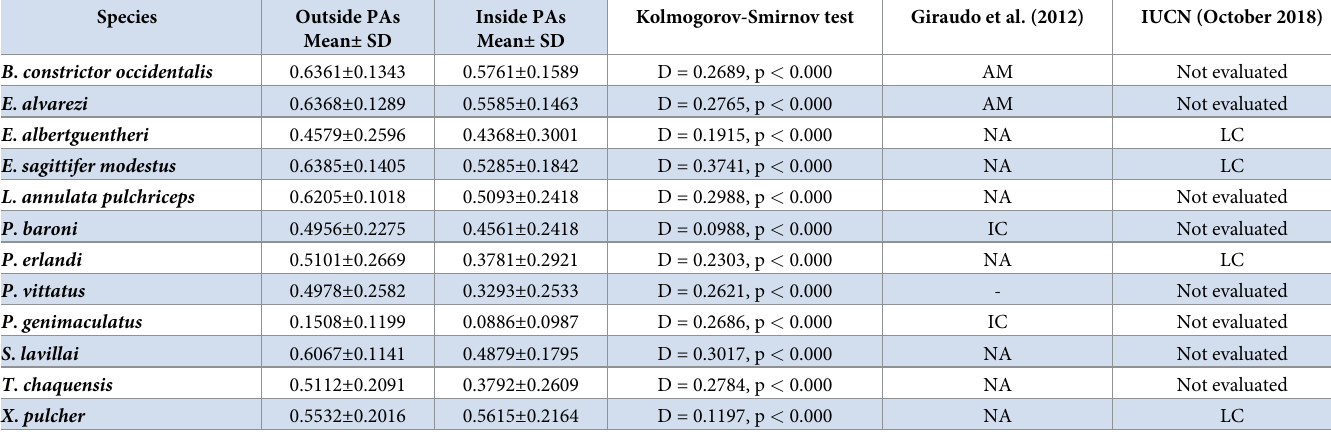
Table 4. Comparison between the suitability values (Mean ± SD) outside and inside PAs.